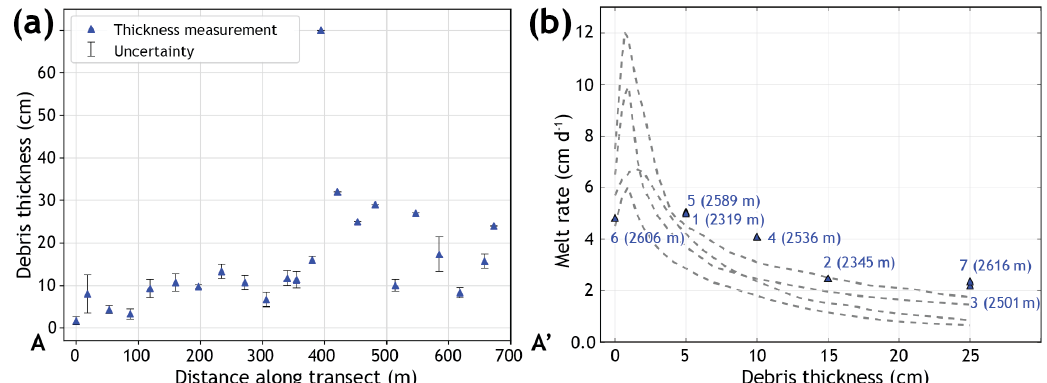
Figure 7. (a) Debris thickness along the upper transect (Fig. 1). Uncertainty bars represent the standard deviation of three measurements per location for depths < 20cm. (b) Ablation of seven stakes over the time period 5 July–22 August 2017 (for locations see Fig. 1). For comparison the curves of Rakhiot Glacier, Barpu Glacier, Kaskawalsh Glacier, and Isfallsglaciären are displayed (adapted from Mattson et al., 1993).